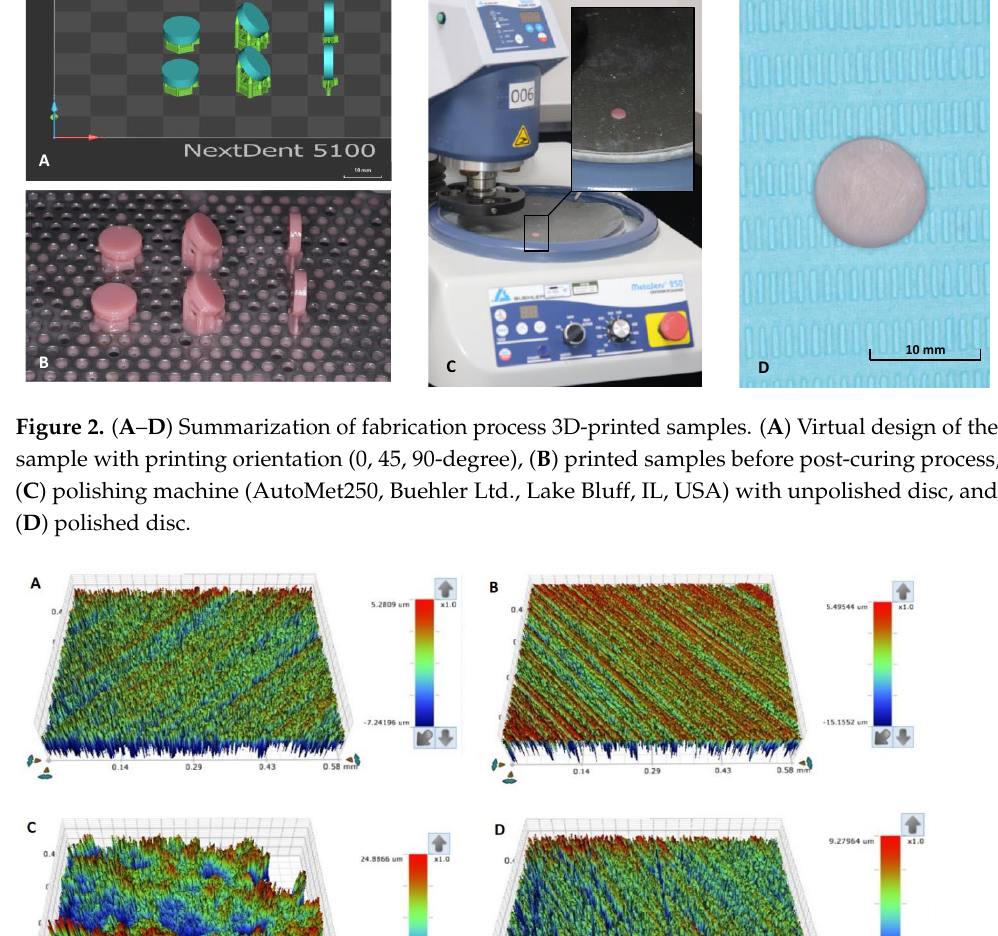
Figure 3. ( A – D ) Representative surface roughness images of scanned areas of HP and ASIGA groups at 120 min. ( A ) HP, ( B ) 0-degree, ( C ) 45-degree, ( D ) 90-degree.